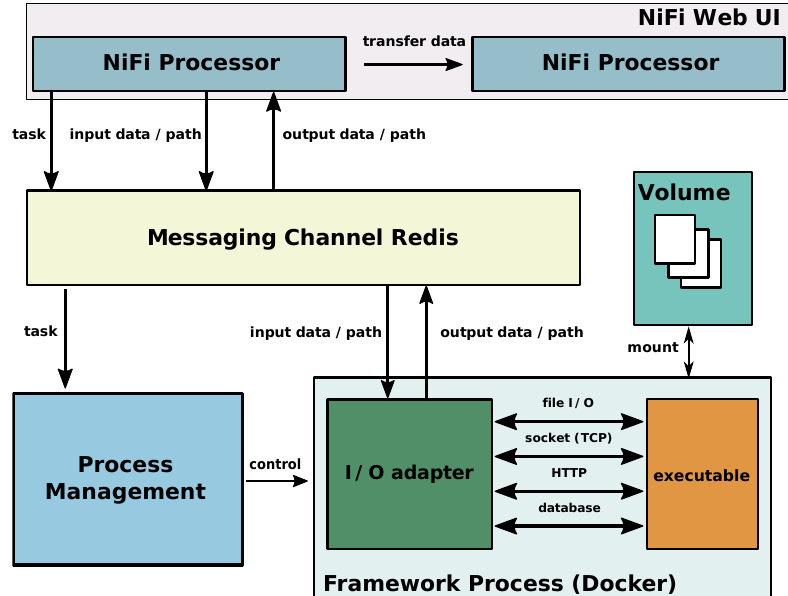
Figure 3. Architecture of the